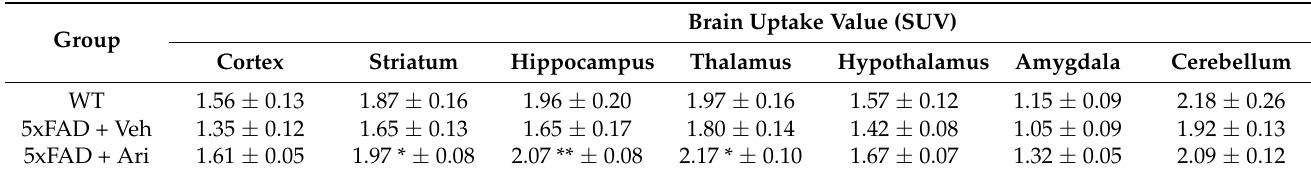
Table 1. Comparison of the regional SUV